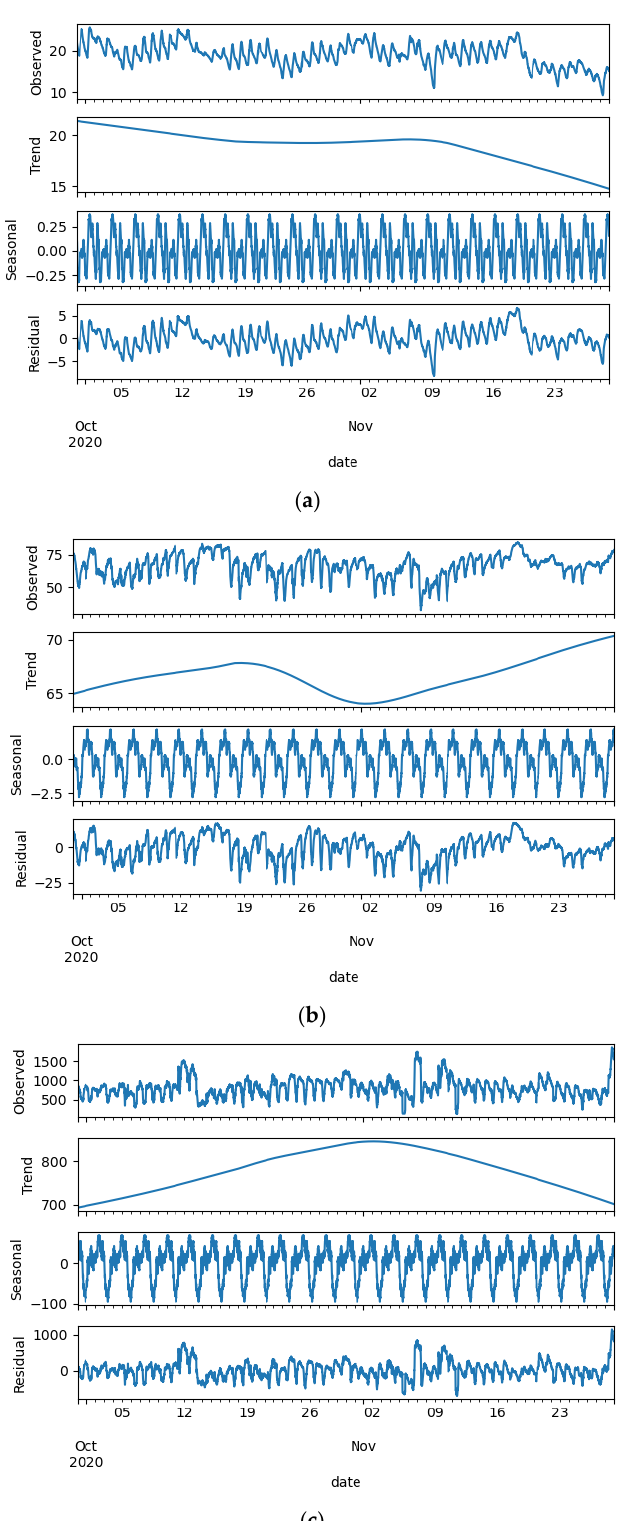
Figure 8. The decomposition results for the rabbit house environmental parameters. ( a ) Temperature decomposition diagram, ( b ) Humidity decomposition diagram, ( c ) Concentrations of carbon dioxide decomposition